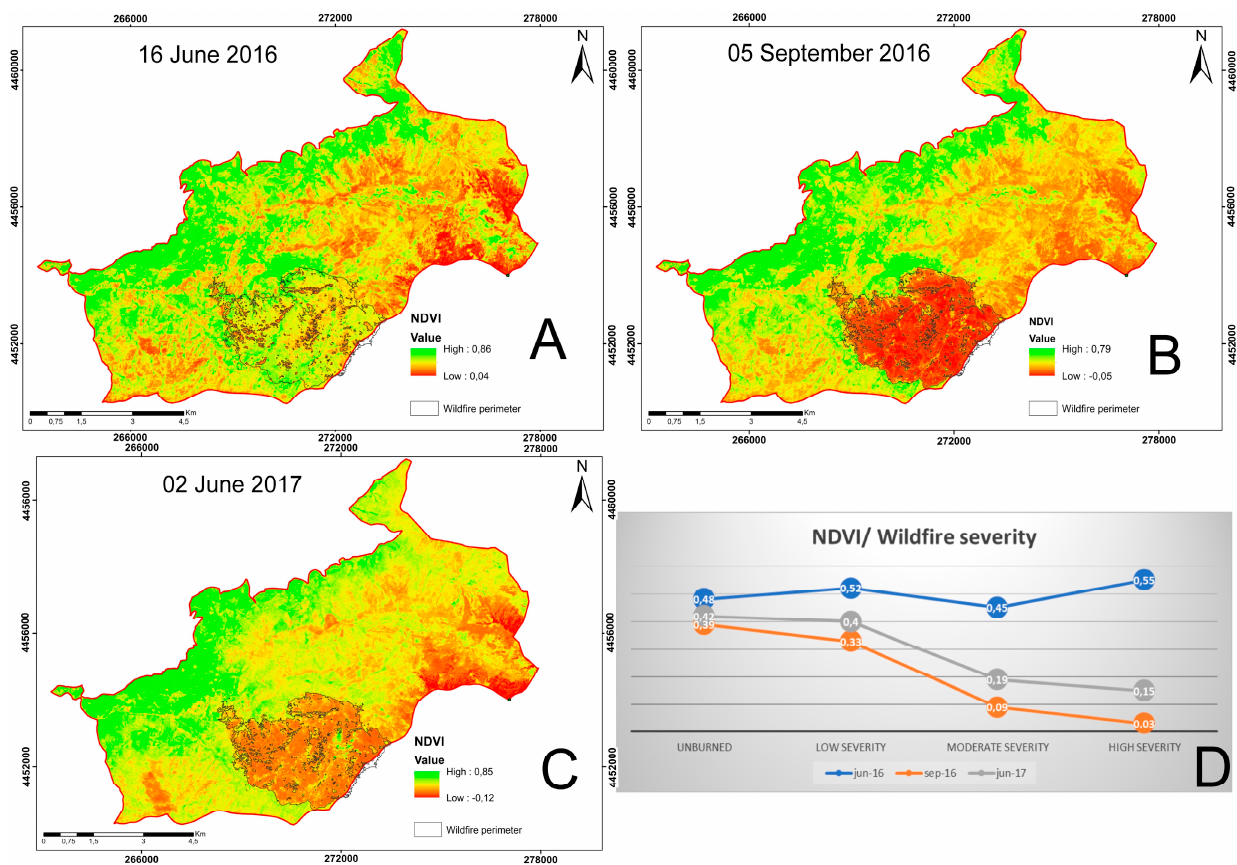
Figure 4. ( A ) NDVI 16 June 2016; ( B ) NDVI 5 September 2016; ( C ) NDVI 2 June 2017; ( D ) Graph of Table 3. the covariation of vegetation and climatology factors versus erosion data in 2017 was studied. The results of Pearson correlation between C factor, NDVI, R factor, erosion and fire severity are presented in Table 2.